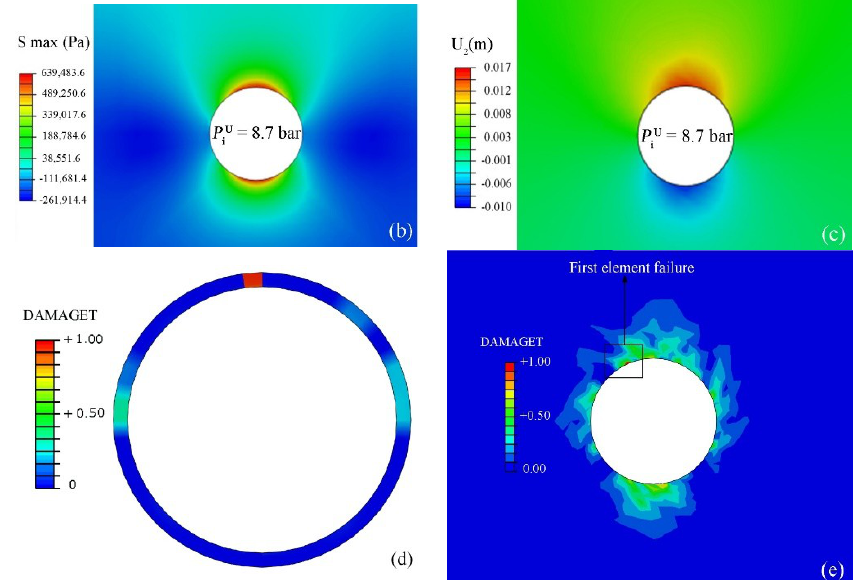
Figure 8. ( a ) The bearing capacity of the tunnel; ( b , c ) maximum stress and vertical displacement contours in the surrounding rock in a steady-state condition; ( d , e ) crack formation in the lining and rock.